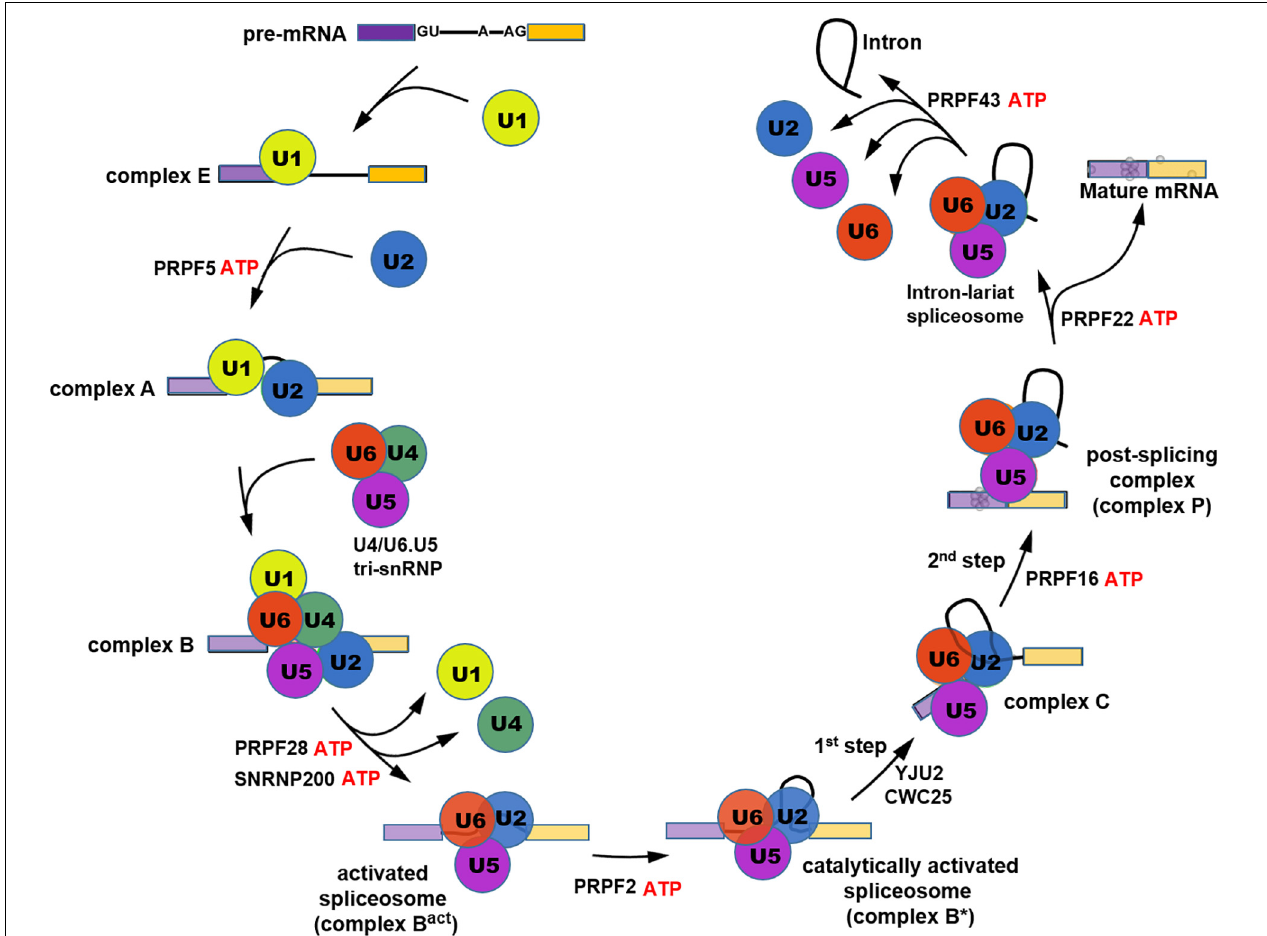
FIGURE 1 | Schematic illustration showing the process of pre-mRNA splicing